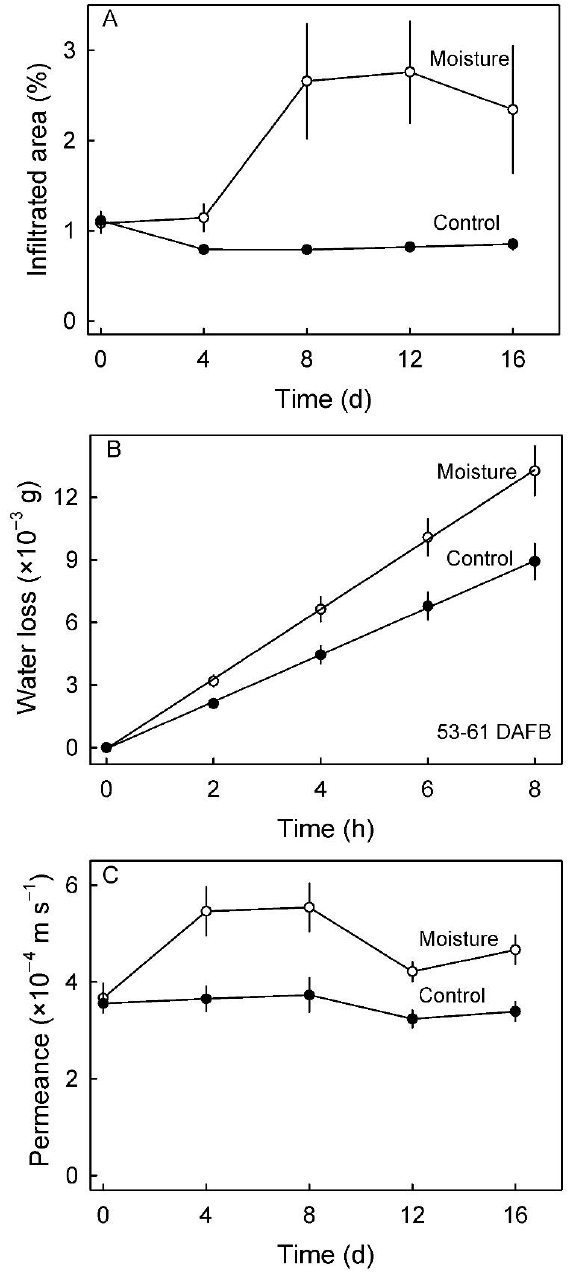
Figure 2. ( A ) Time course of change in moisture-induced cuticular microcracking of fruit of mango cv. apple. ( B ) Time course of water loss through moisture-exposed fruit skins. Skins not exposed to moisture served as controls. The fruits were exposed to moisture for 8 d beginning at 53 days after full bloom (DAFB). ( C ) Time course of change in the water vapor permeance of the fruit skin during moisture exposure. Fruit was exposed to moisture for 4, 8, 12 and 16 d. Microcracking was indexed by quantifying the area infiltrated with aqueous acridine orange. Fruit surfaces that remained dry served as controls. N = 40 (microcracks) and 13–15 (permeance). Data represent the means ± SE.